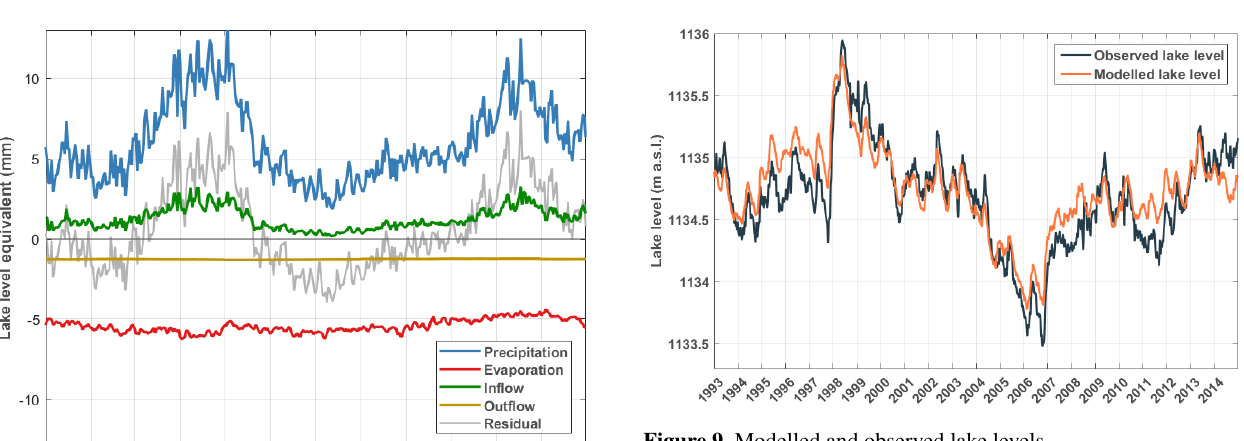
Figure 9. Modelled and observed lake levels.